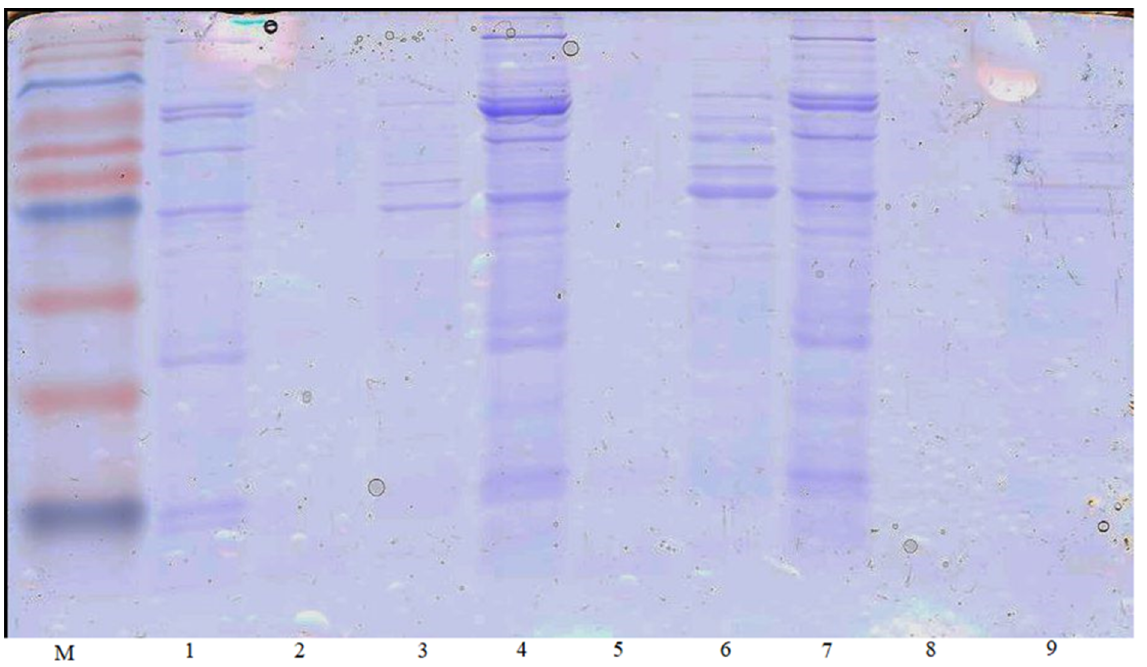
Figure 3. Protein profiles of fractions obtained by SDS-PAGE. M—molecular weight marker; 1—DB (undigested); 2—DB (gastric phase); 3—DB (intestinal phase); 4—DB + ES (undigested); 5—DB + ES (gastric phase); 6—DB + ES (intestinal phase); 7—DB + CC (undigested); 8—(gastric phase); 9—DB + CC (intestinal phase).